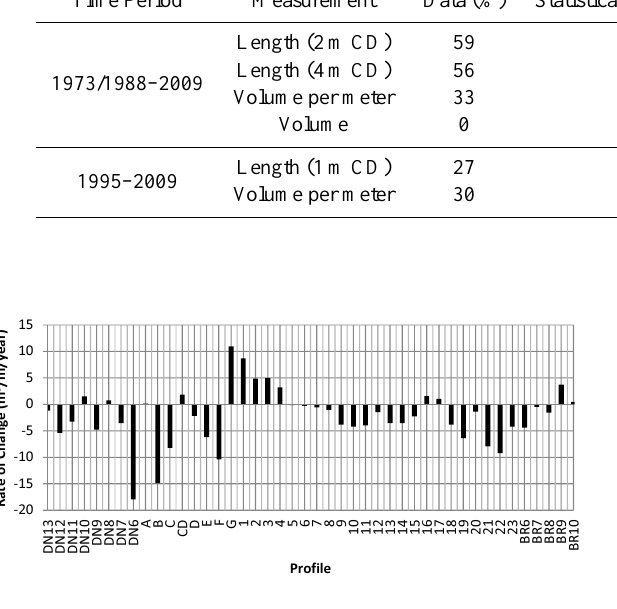
Fig. 5. Profile volume per meter annual rate of change (1973/1988- Fig. 6. Profile volume per meter annual rate of change (1995-2009)